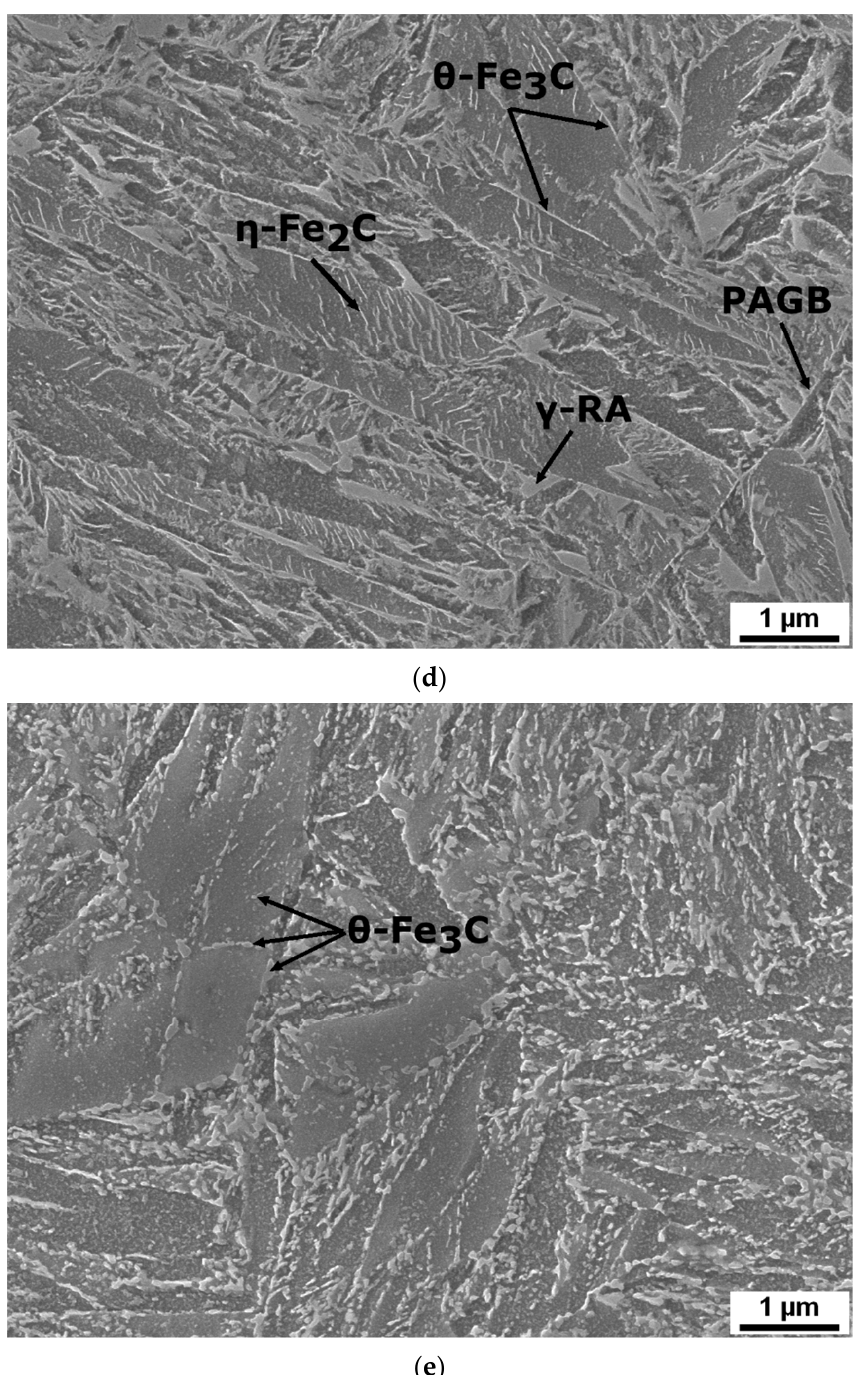
Figure 5. Development of microstructure of steel B during heat treatment (SEM images): after quenching ( a ) and tempering at 200 °C ( b ), 300 °C ( c ), 400 °C ( d ), and 500 °C ( e ). Martensitic matrix and RA are visible after quenching. The transition carbides and cementite form during tempering whereas the amount of RA decreases with the increasing tempering temperature.